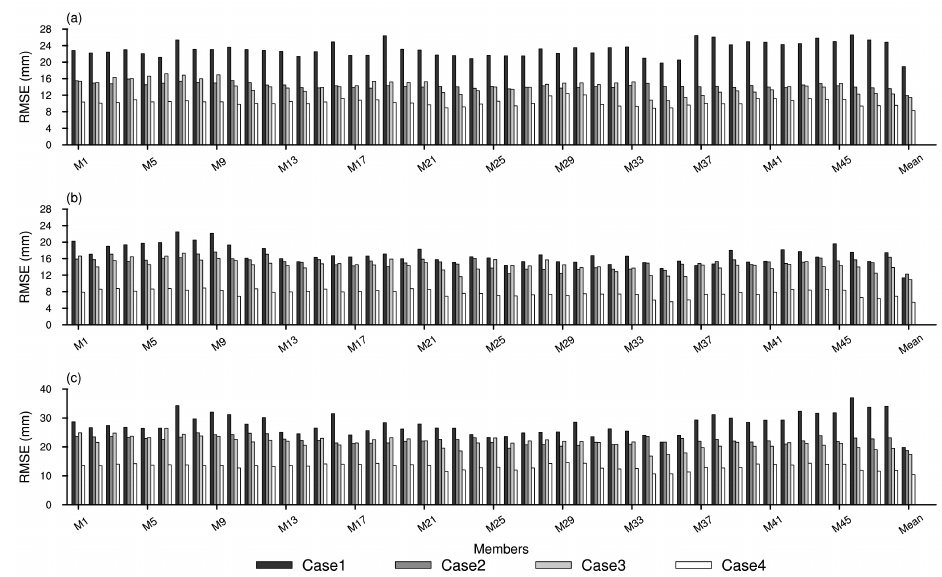
Figure 6. The RMSE (mm) for each ensemble member in Case1 (solid black bar), Case2 (solid dark grey bar), Case3 (solid light grey bar), and Case4 (solid white bar) during 12:00–23:00 UTC ( a ), 00:00–11:00 UTC ( b ) and 24 h ( c ). The result of ensemble mean is also